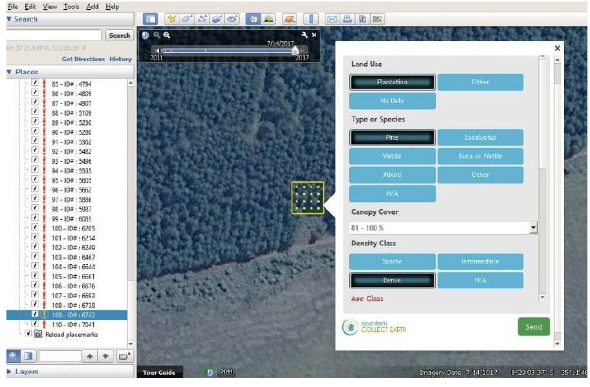
Figure 1. Collect Earth allows filling a structured survey form and facilitates access to Google Earth and other freely available archives of satellite